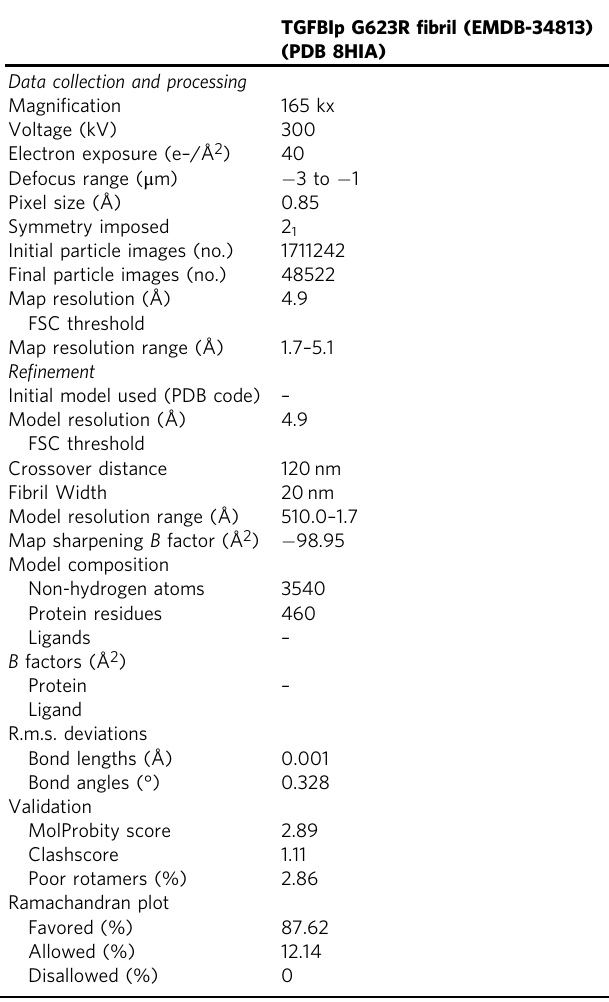
Table 1 NMR and re fi nement statistics for protein